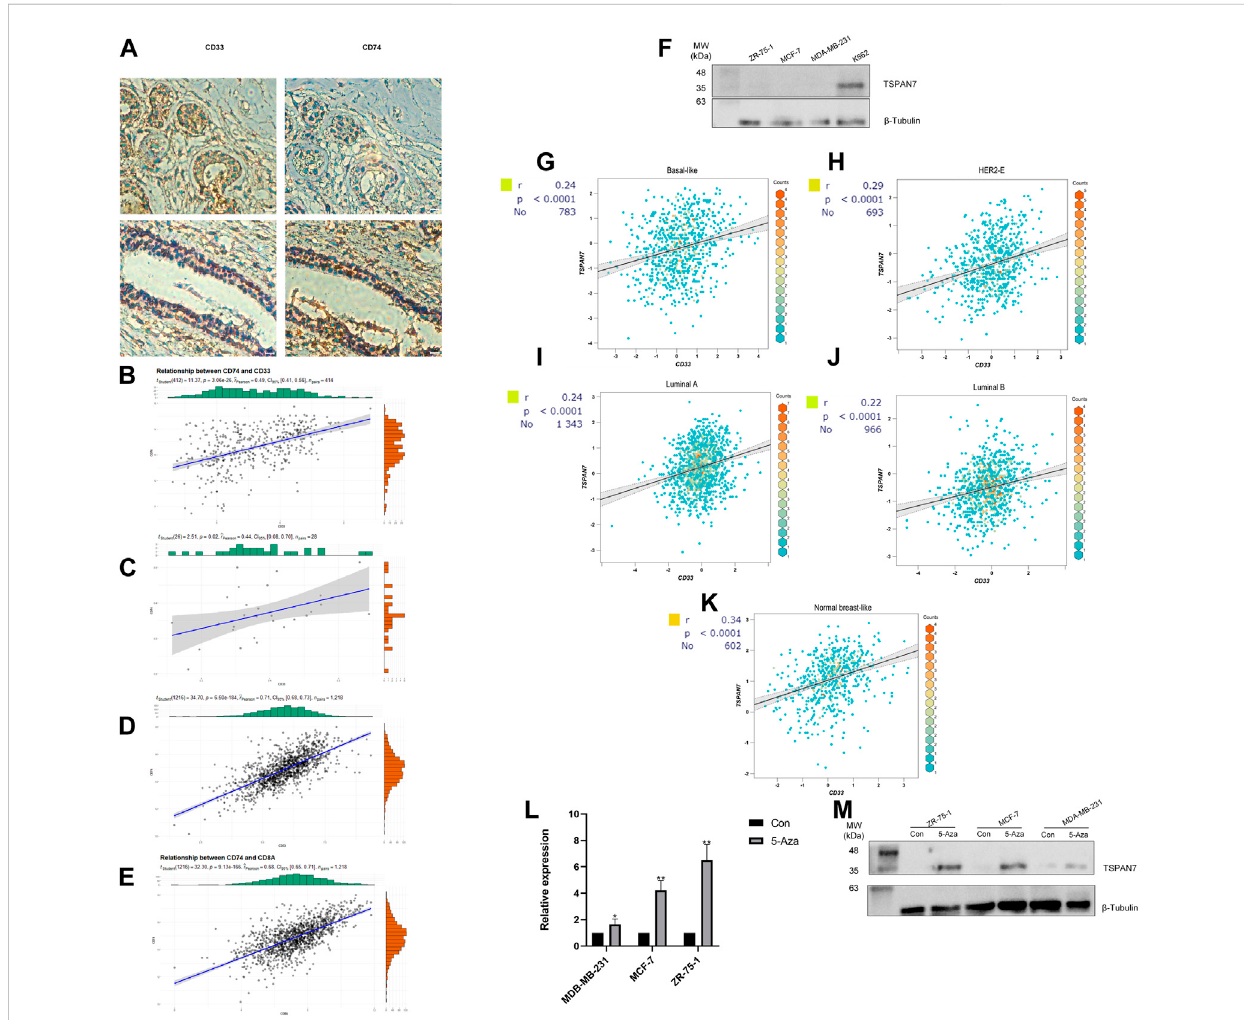
FIGURE 8 Gene expression and correlation. (A) IHC for CD74 and myeloid marker CD33. (B – D) Correlation between the expression of CD74 and CD33 in cohorts(PanelB),IHC(PanelC)andTCGA(PanelD)(Pearsoncorrelationcoef fi cient). (E) CorrelationbetweentheexpressionofCD74andCD8AinTCGA. (F) Western blot analysis of TSPAN7 in cell lysates of myeloid cells and breast cancer cells. (G – K) Correlation between CD33 and TSPAN7 expression of different PAM50 subtypes in bc-GenExMiner. Basal-like subtype (G) ; HER2-enriched subtype (H) ; Luminal A subtype (I) ; Luminal B subtype (J) ; Nromal-likesubtype (K) . (L,M) TSPAN7mRNA (L) andprotein (M) expressionwasupregulatedaftertreatmentwiththedemethylationreagent5-Aza.* p < 0.05,** p < 0.01, by Student ’ s